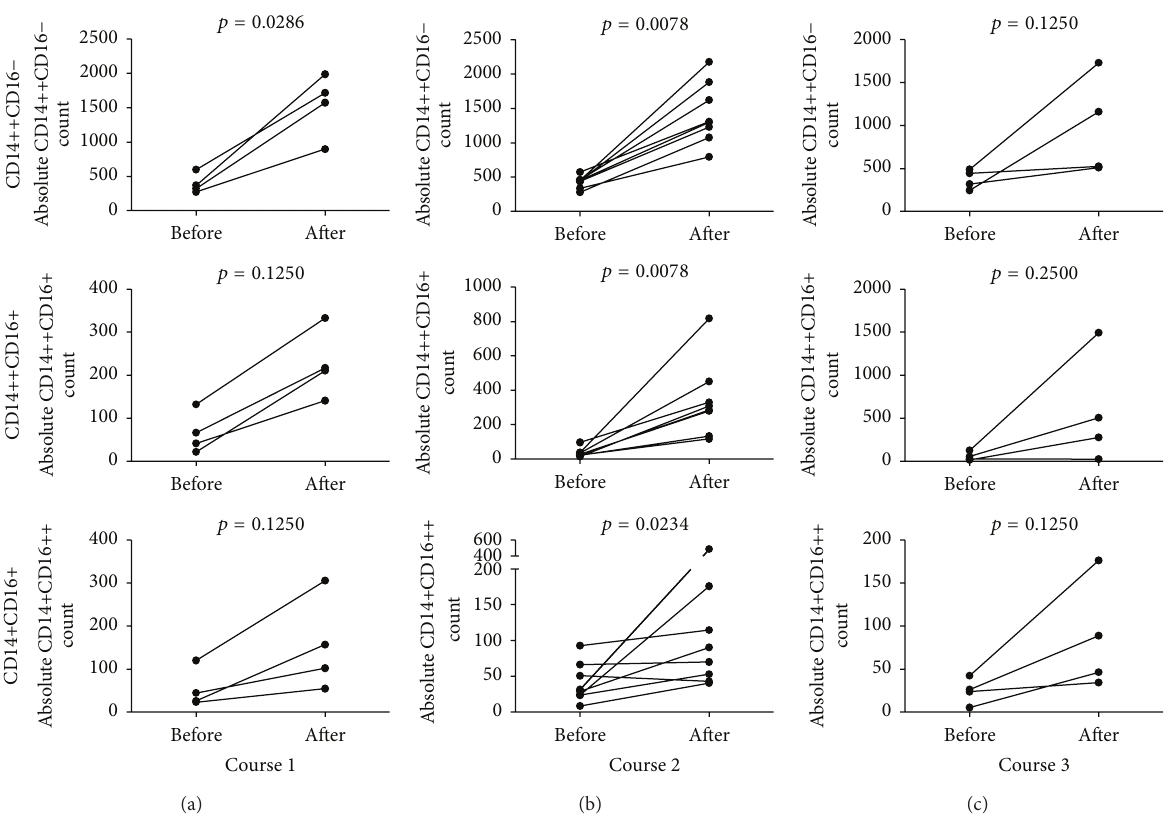
Figure 4: Effect of (a) course 1, (b) course 2, and (c) course 3 of G-CSF administration on absolute numbers of CD14++CD16 − (upper row), CD14++CD16+ (middle row), and CD14+CD16++ (bottom row) monocytes in pediatric patients with MD.